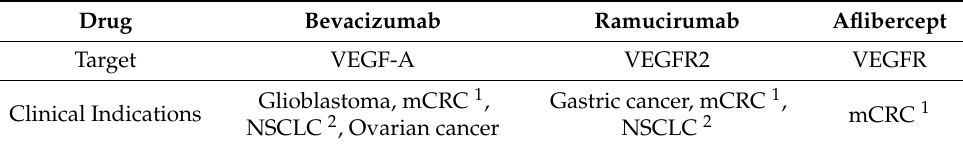
Table 4. Targeted therapy of VEGF family and their